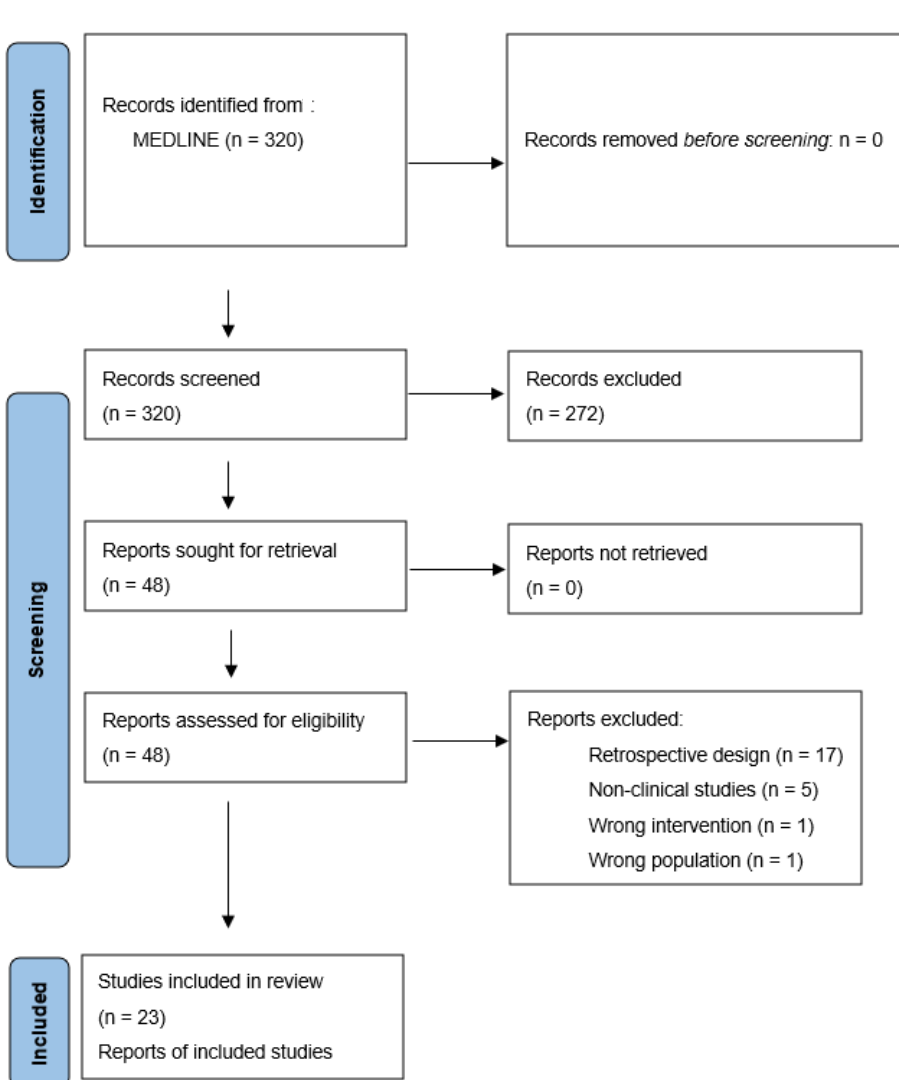
Figure 1. PRISMA flow diagram illustrating the study selection process on MEDLINE (www.pubmed.gov).